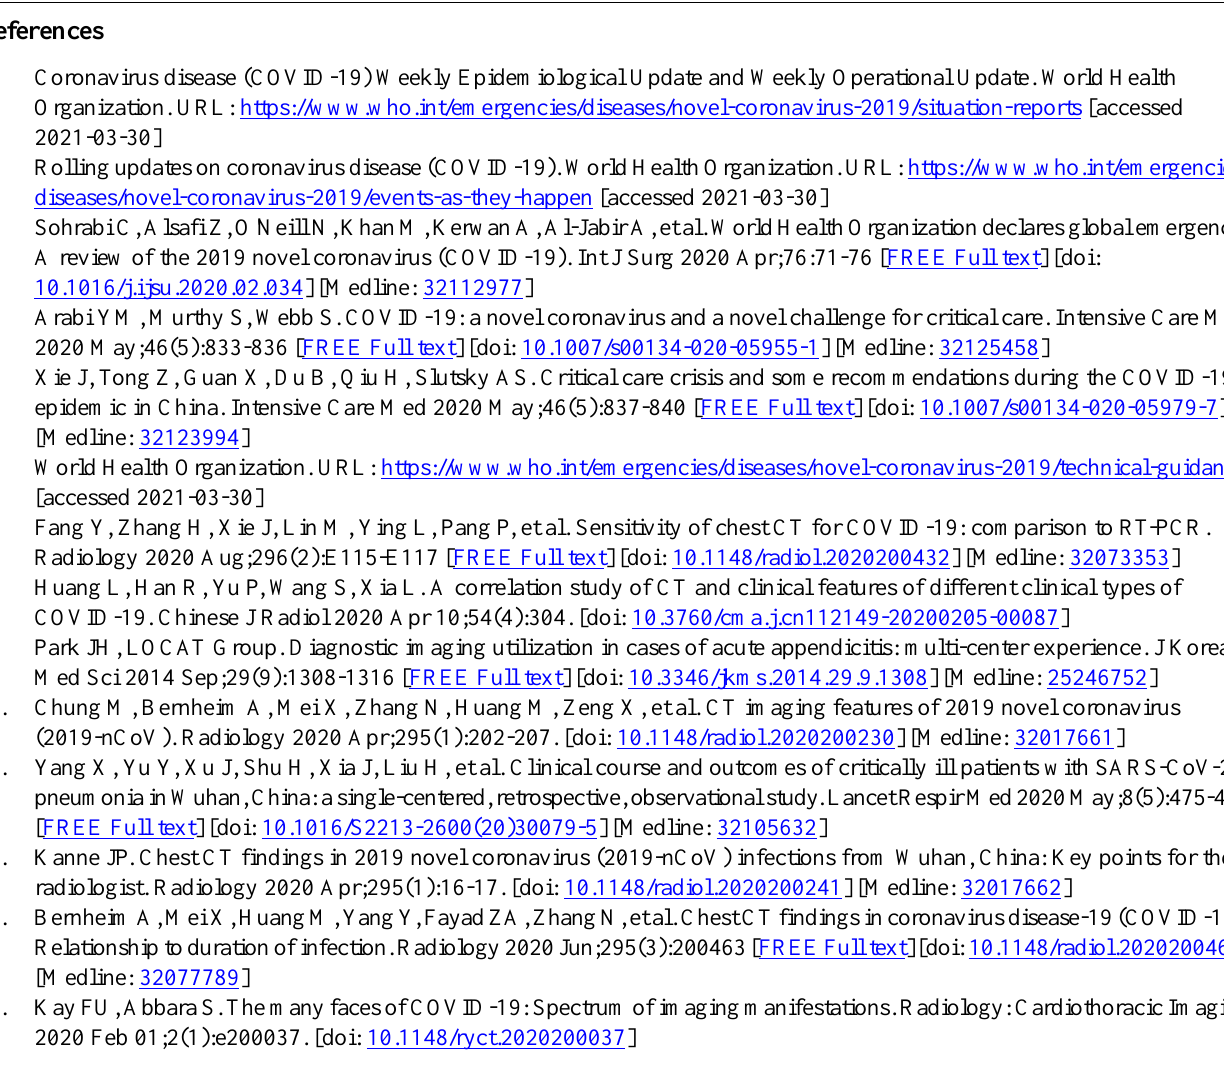
Table S1. Characteristics of included